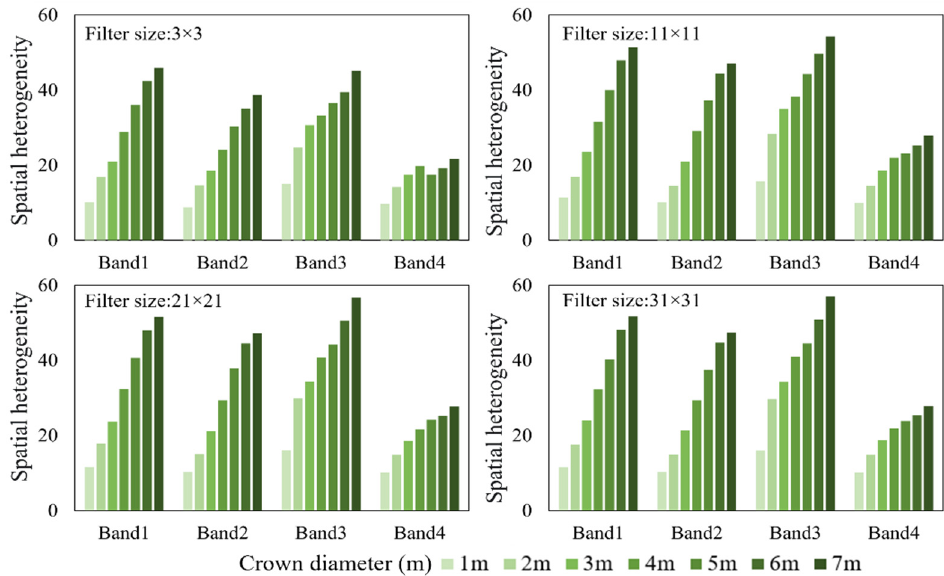
Figure 5. Relationships between the CD and SH of simulated images.